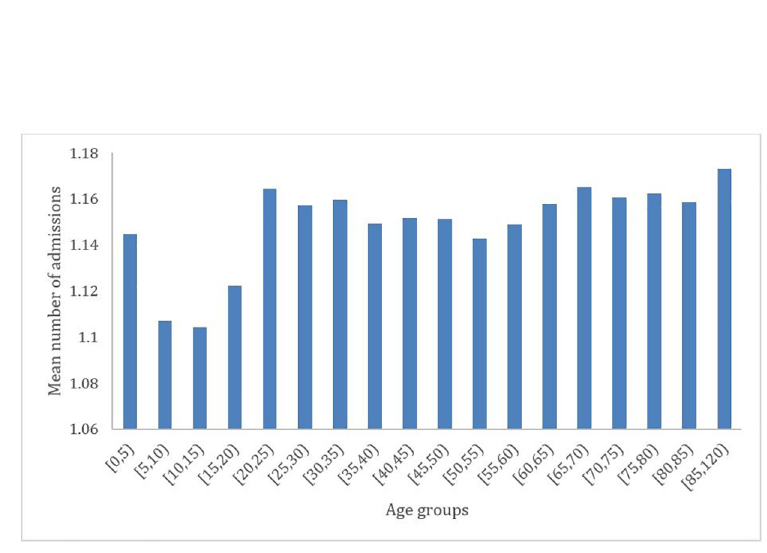
Fig 1. Mean number of admissions per patient related to falls, between 2010 and 2018, in the Portuguese